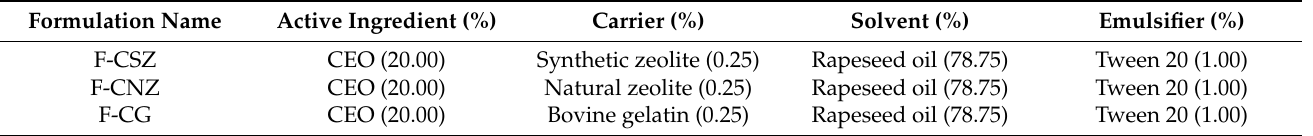
Table 1. Design of CEO EC